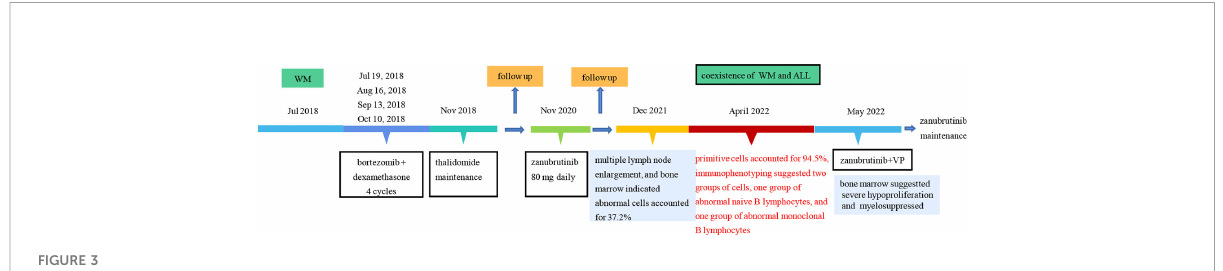
FIGURE 3 The treatment timeline of the patient.